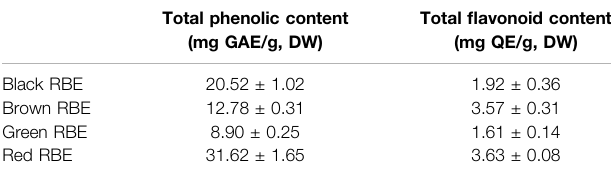
TABLE 1 | Total phenolic and fl avonoid contents in different pigmented RBEs. Total phenolic content (mg GAE/g,